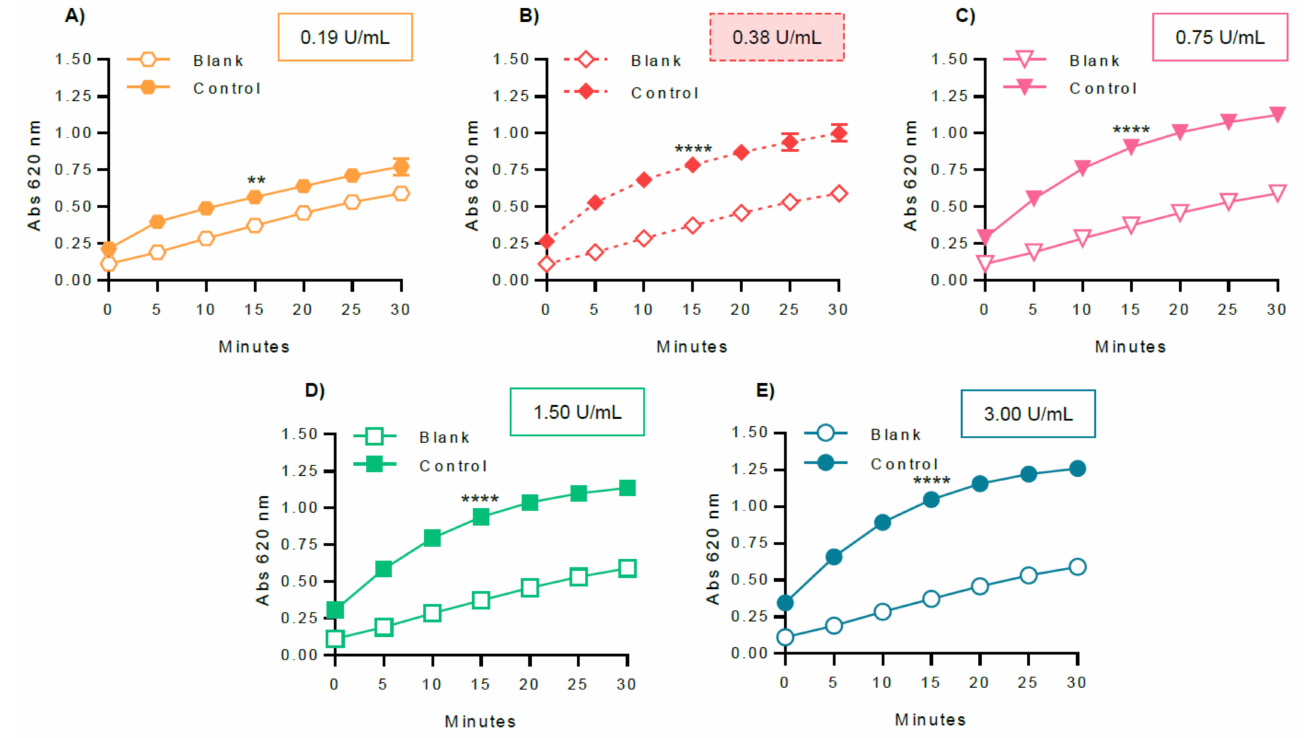
Figure 5. Optimization of the GPa concentration: ( A ) 0.19 U/mL, ( B ) 0.38 U/mL, ( C ) 0.75 U/mL, ( D ) 1.50 U/mL, and ( E ) 3.00 U/mL. Glucose 1-phosphate, glycogen, and temperature were fixed at 0.50 mM, 1.00 mg/mL, and 37 ◦ C, respectively. The blank contained the same constituents as the control, except the enzyme. The obtained results represent at least four independent experiments and were graphically represented as mean ± SEM. ** p < 0.01; **** p < 0.0001 when compared with the blank (without enzyme) at 15 min of